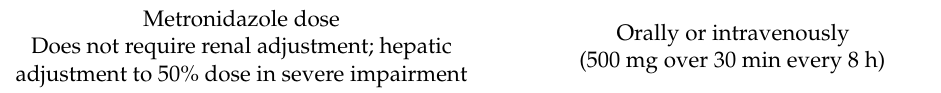
Table 5. Metronidazole dosing and PK/PD